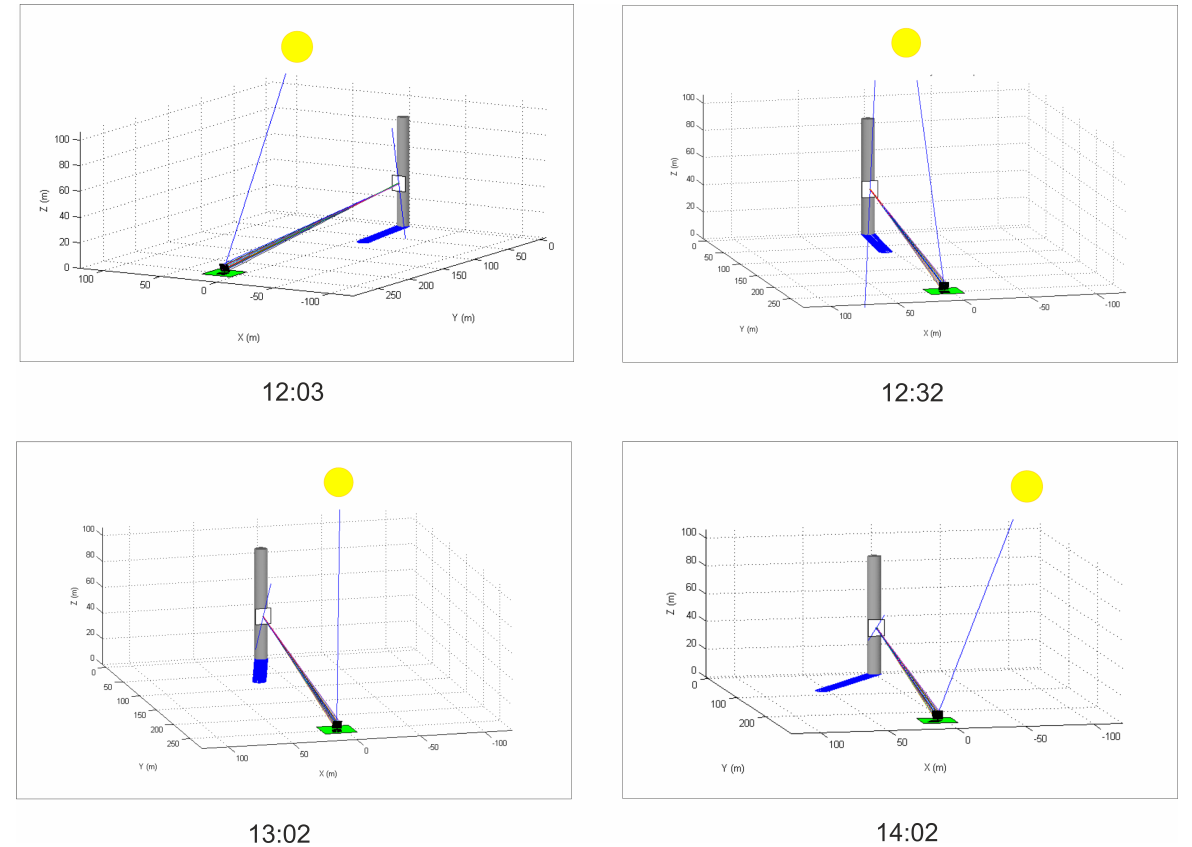
Figure 6. Scheme of simulation for DNI forecasting on target (9 March 2017 at 12:02